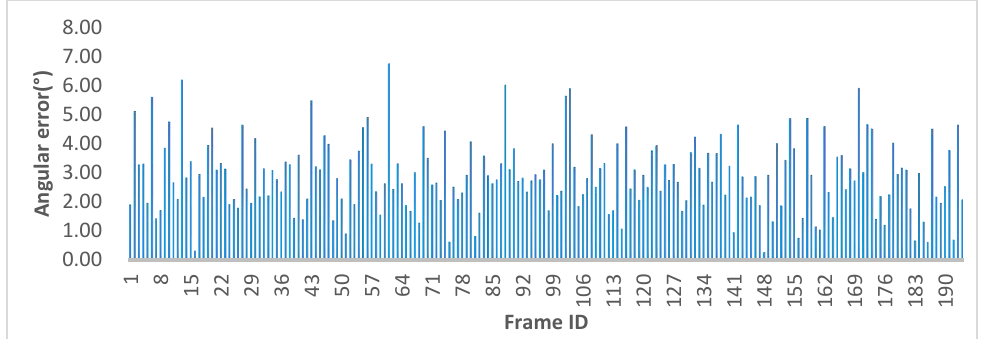
Figure 18. Angular error of deep learning position network (PoseNet) in closed round hall.